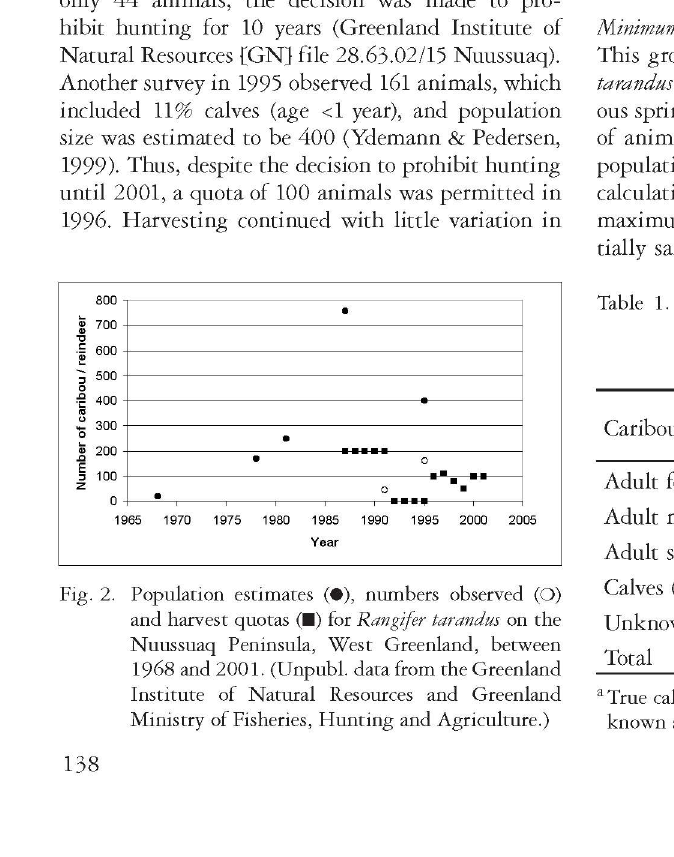
Fig. 2. Population estimates (•), numbers observed (O) and harvest quotas (•) for Rangifer tarandus on the Nuussuaq Peninsula, West Greenland, between 1968 and 2001. (Unpubl. data from the Greenland Institute of Natural Resources and Greenland Ministry of Fisheries, Hunting and